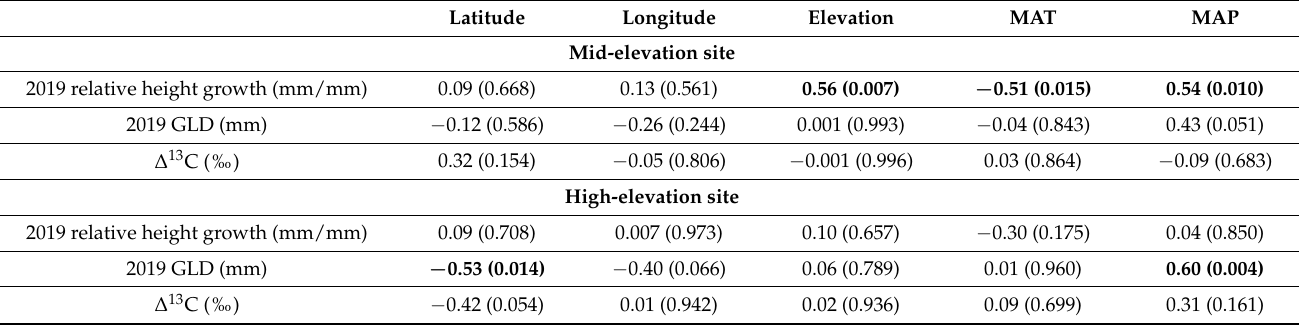
Table 4. Correlation coefficients between provenance environmental characteristics and trait means for mid and high elevation sites. Values in parentheses are p values. Boldface type indicates significance ( p < 0.05). Ground line diameter (GLD); carbon isotope discrimination ( ∆ 13 C).